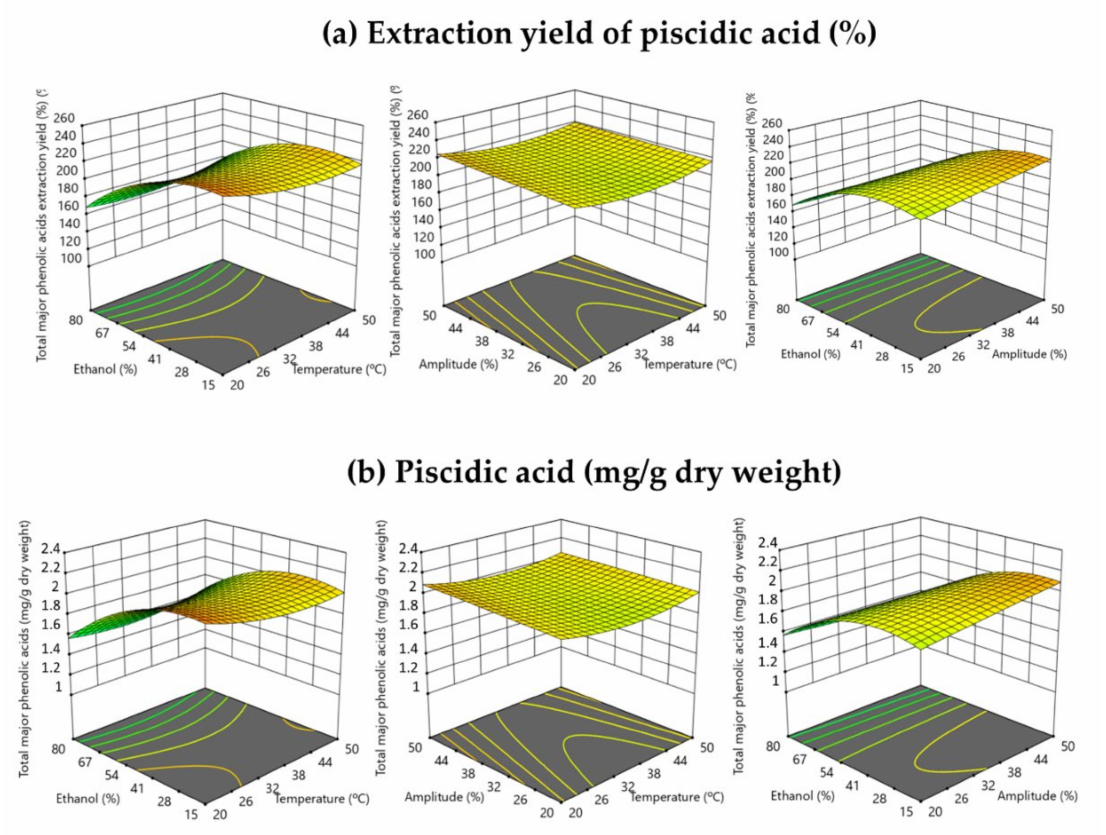
Figure 3. Response surface graph illustrating the effect of the three independent variables (amplitude (%), temperature ( ◦ C) and ethanol in solvent (%, v / v )) on piscidic acid ( a ) extraction yield (%) and content (mg/g dry